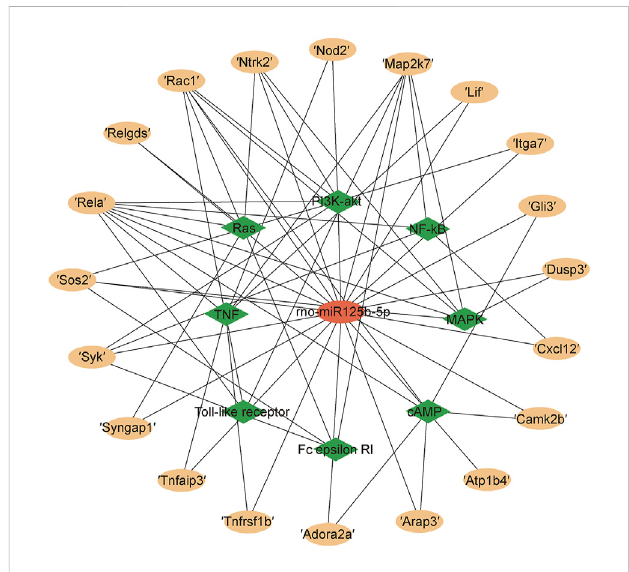
FIGURE 9 Target mRNAs for rno-miR125b-5p in signaling